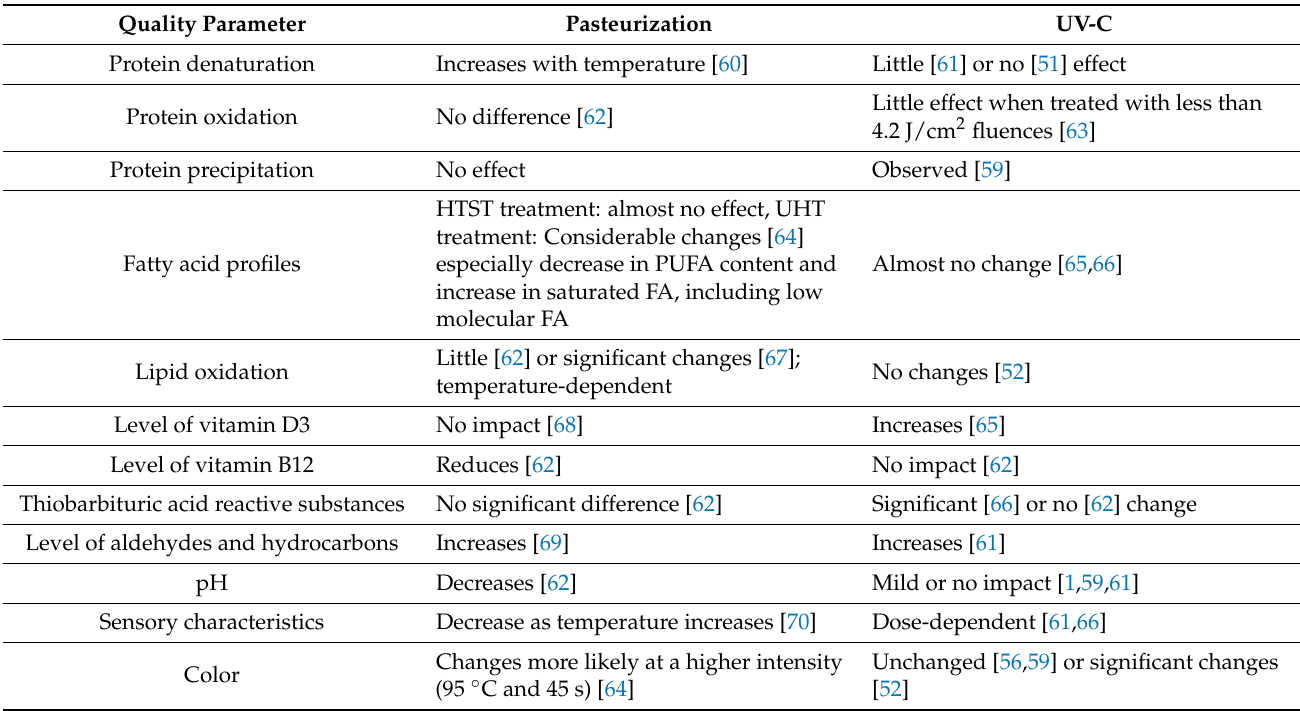
Table 3. An overview of the effects of UV-C radiation and pasteurization on the components, physicochemical parameters, and sensory attributes of milk and dairy